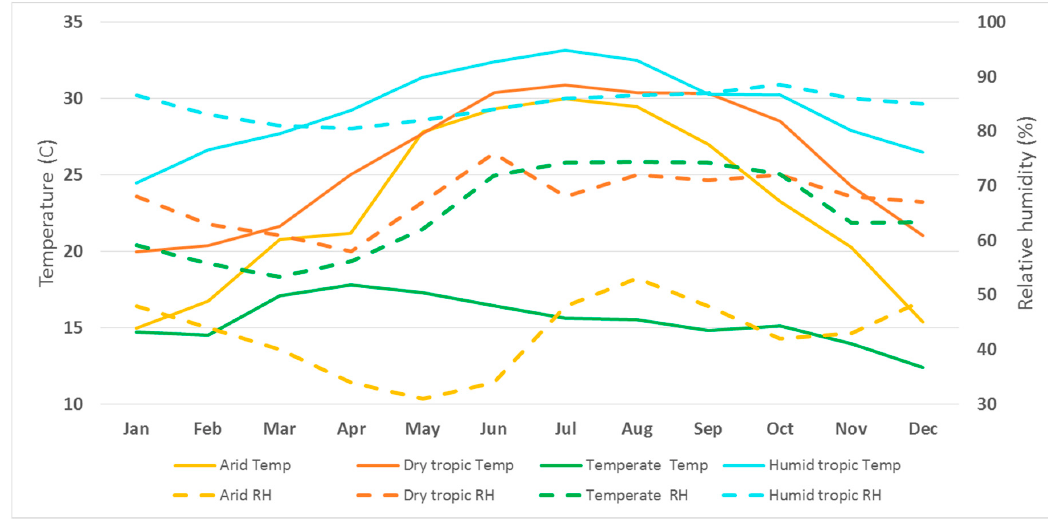
Figure 2. Monthly average temperature (Temp) and relative humidity (RH) for the four main climates in Mexico.